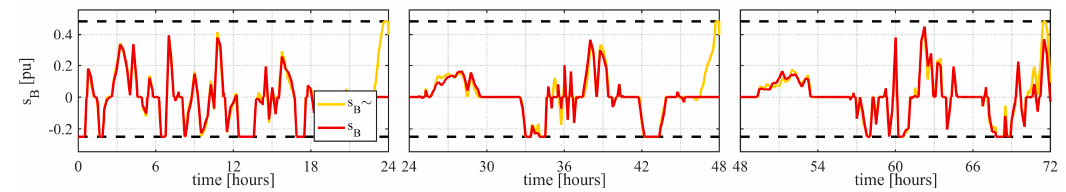
Figure 7. The B power profiles achieved by OPEM over three days: s ̃ B (orange, forecast at the start of each day) and s B (red, actual evolution).